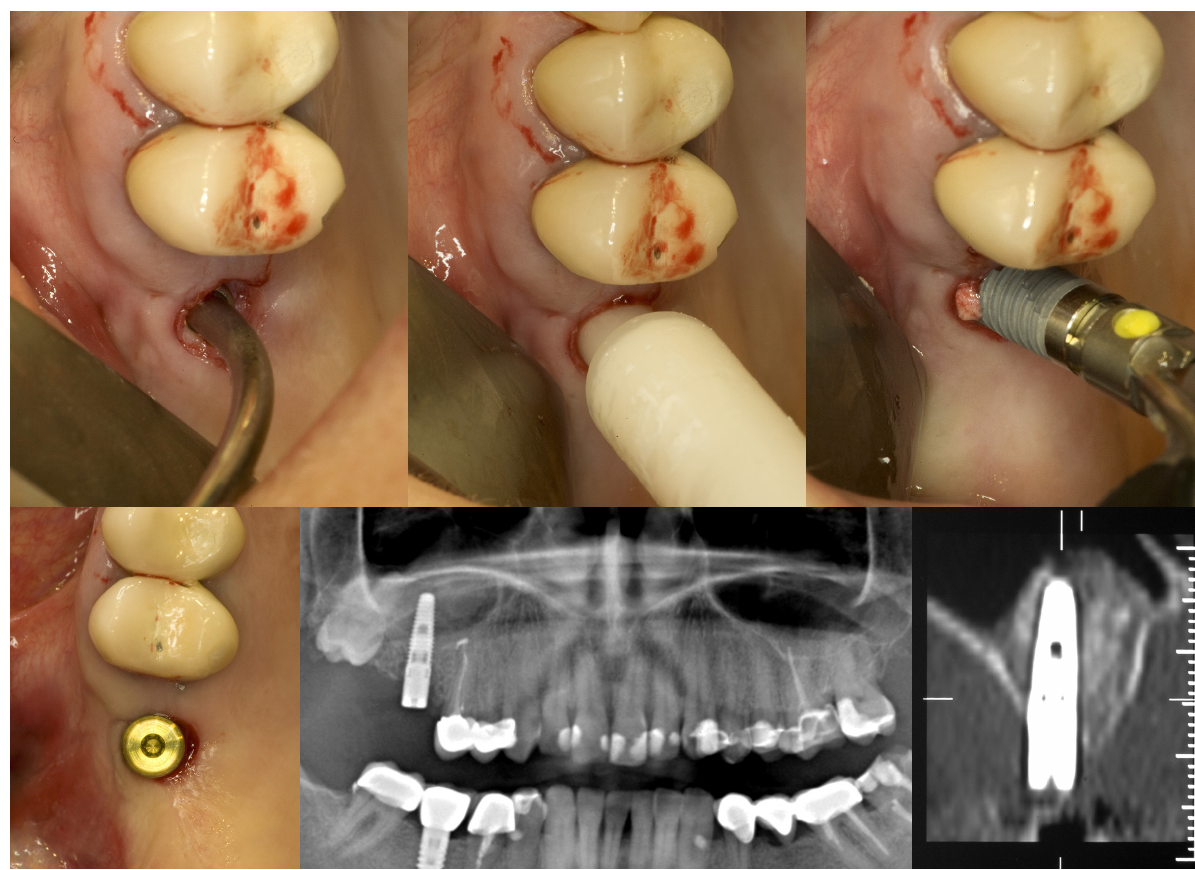
Figure 2. GPT and implant placement in the right upper first molar region of a 43-year old